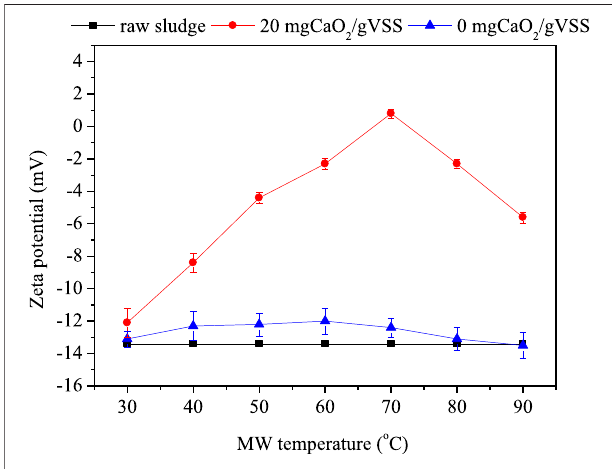
FIGURE 7 | Fourier-transform infrared spectra of raw sludge, CaO 2 (20 mg/gVSS) treated sludge, and CaO 2 (20 mg/gVSS)/MW (70 ° C) treated